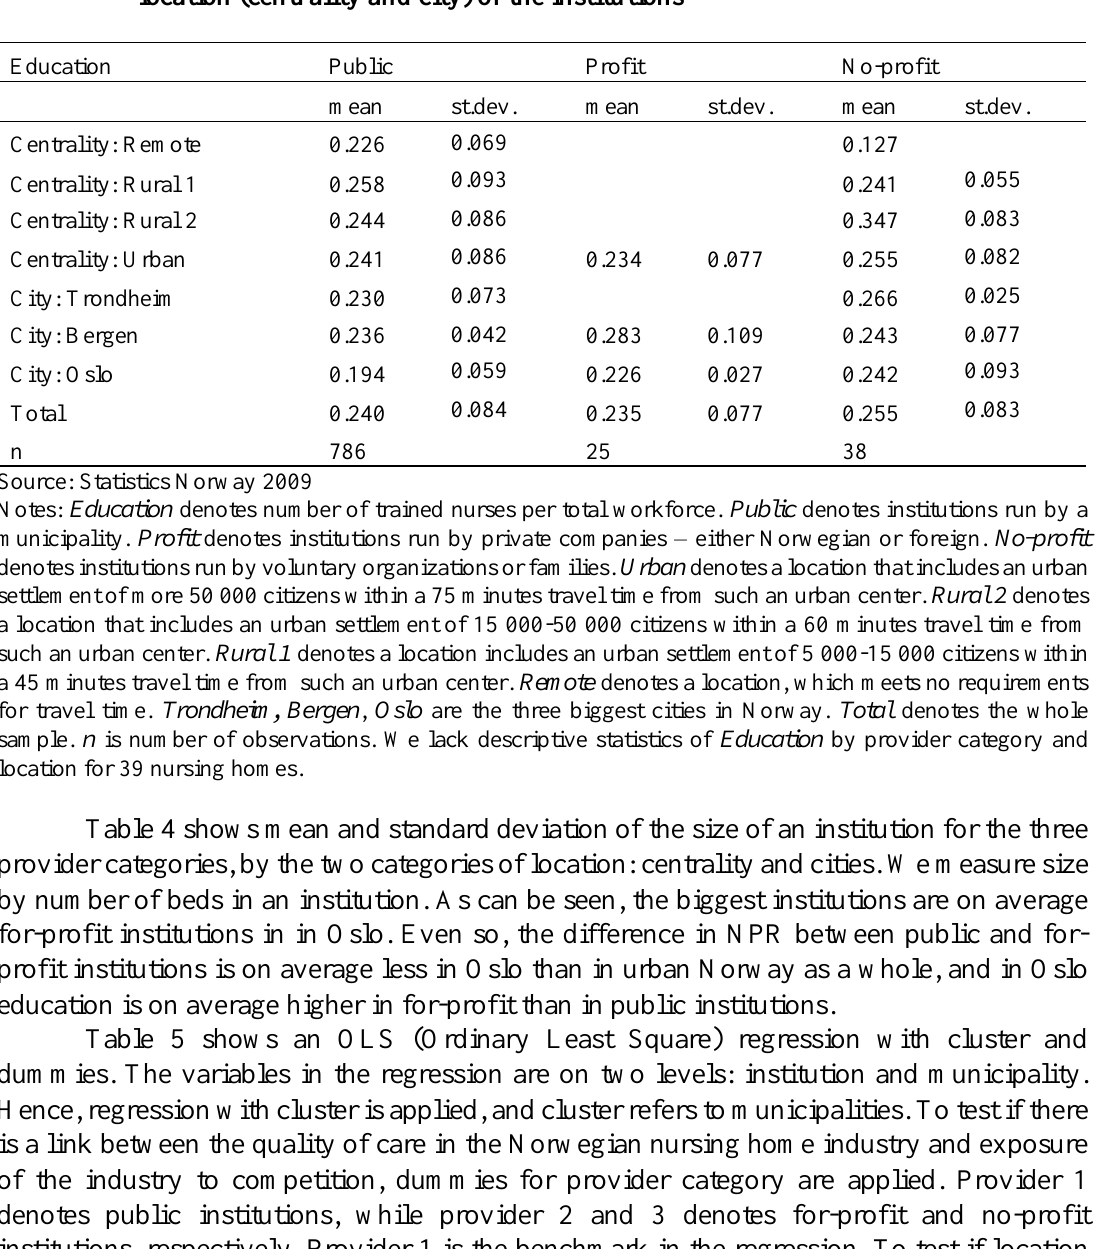
Table 3: Mean and standard deviation of education, by provider category and location (centrality and city) of the